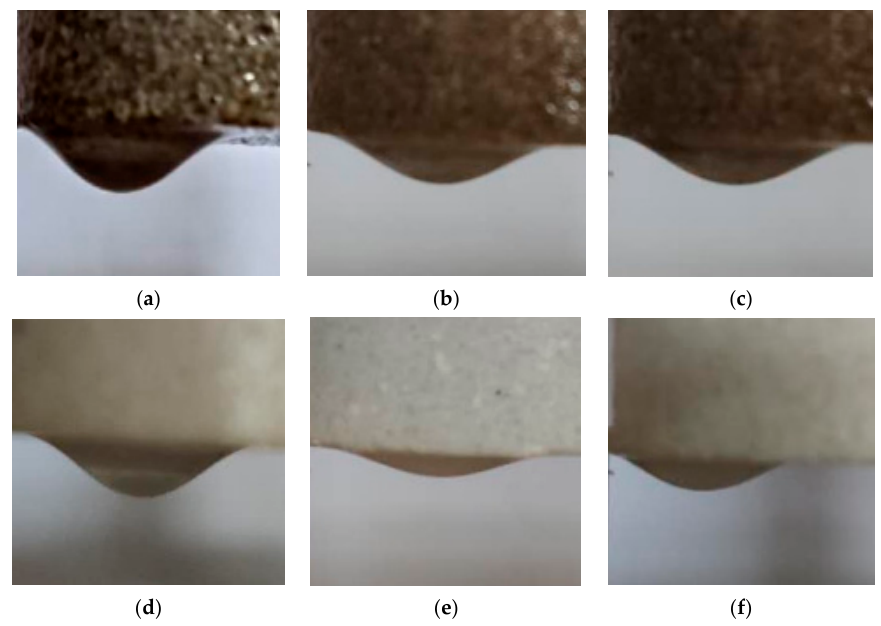
Figure 8. ( a – c ) The contact angles of target samples; ( d – f ) the contact angles of synthetic samples at standard conditions.